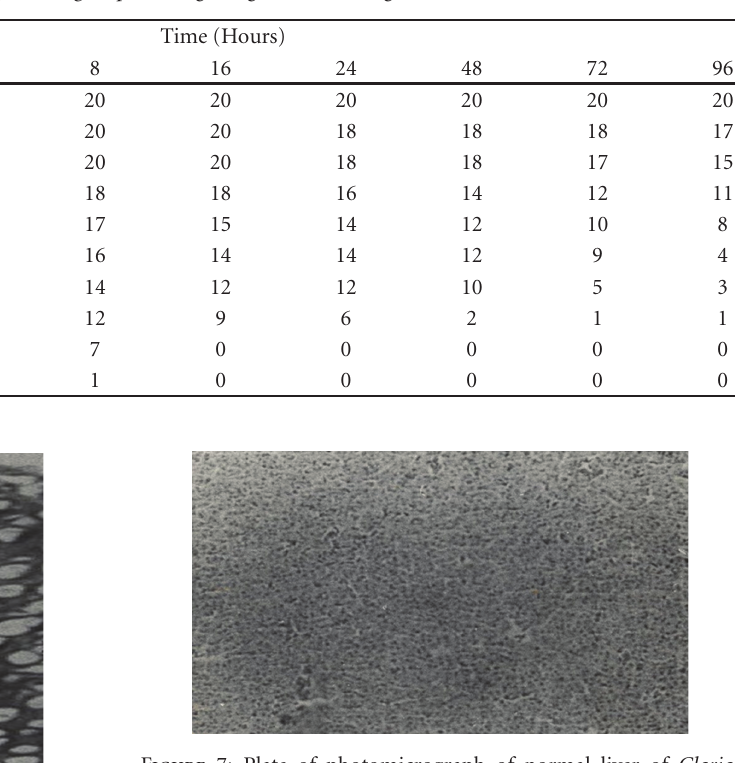
Figure 7: Plate of photomicrograph of normal liver of Clarias gariepinus after 12 weeks showing hepatocytes arranged in grandu- lar pattern and other cells normal and systematically arranged.